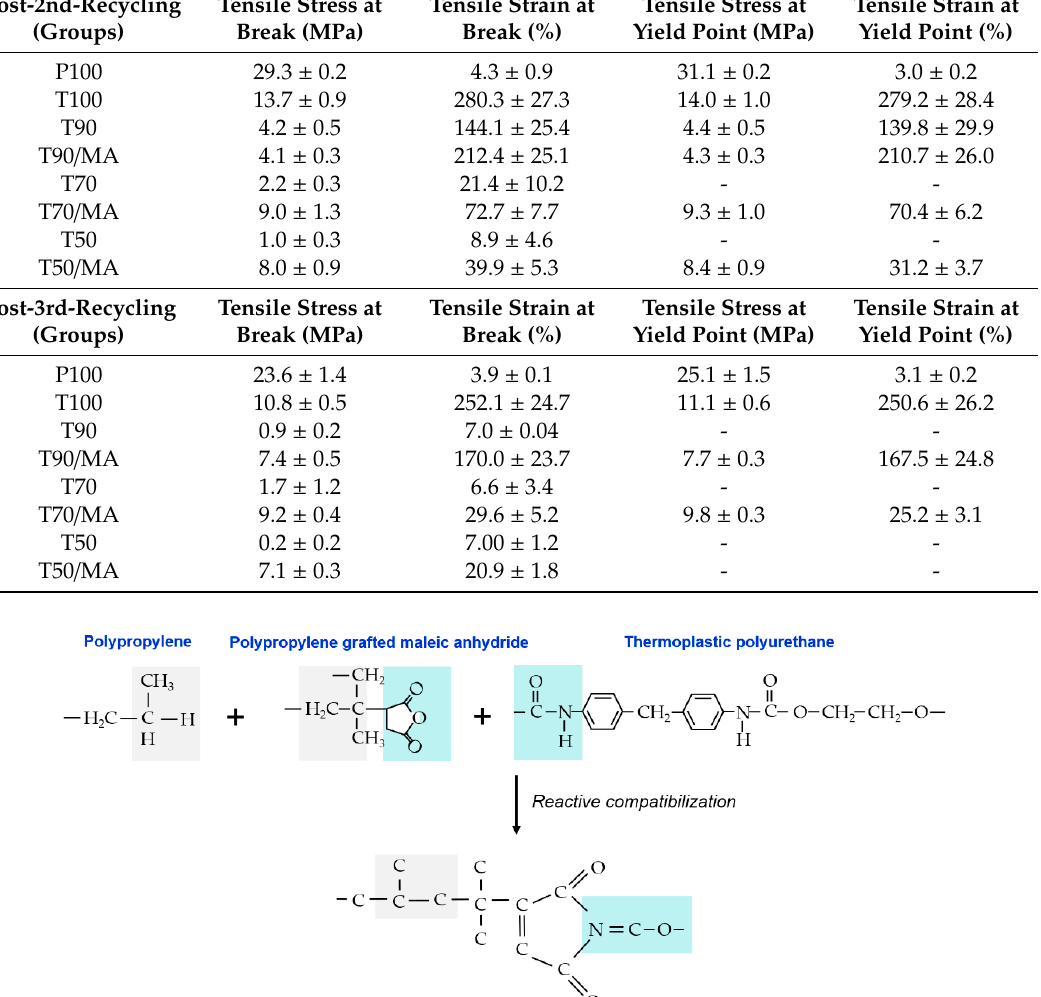
Table 2. Tensile stress and tensile strain of post-2nd-recycling and post-3rd-recycling T / P and T / P / MA blends.